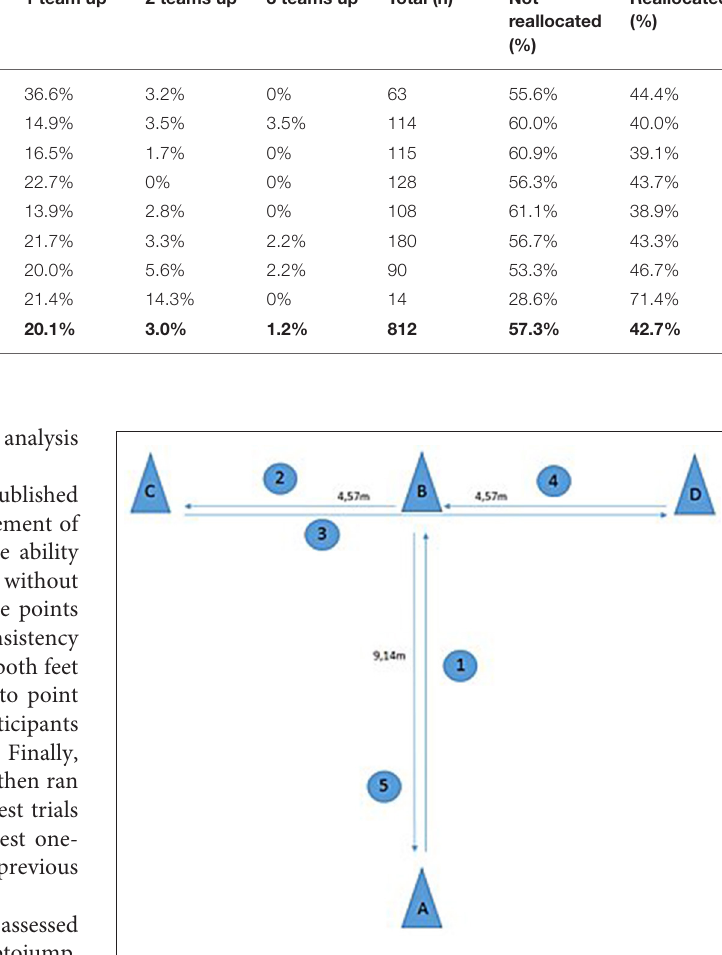
TABLE 5 | Overview of the category changes that result from the new allocation method. Squad 3 teams down